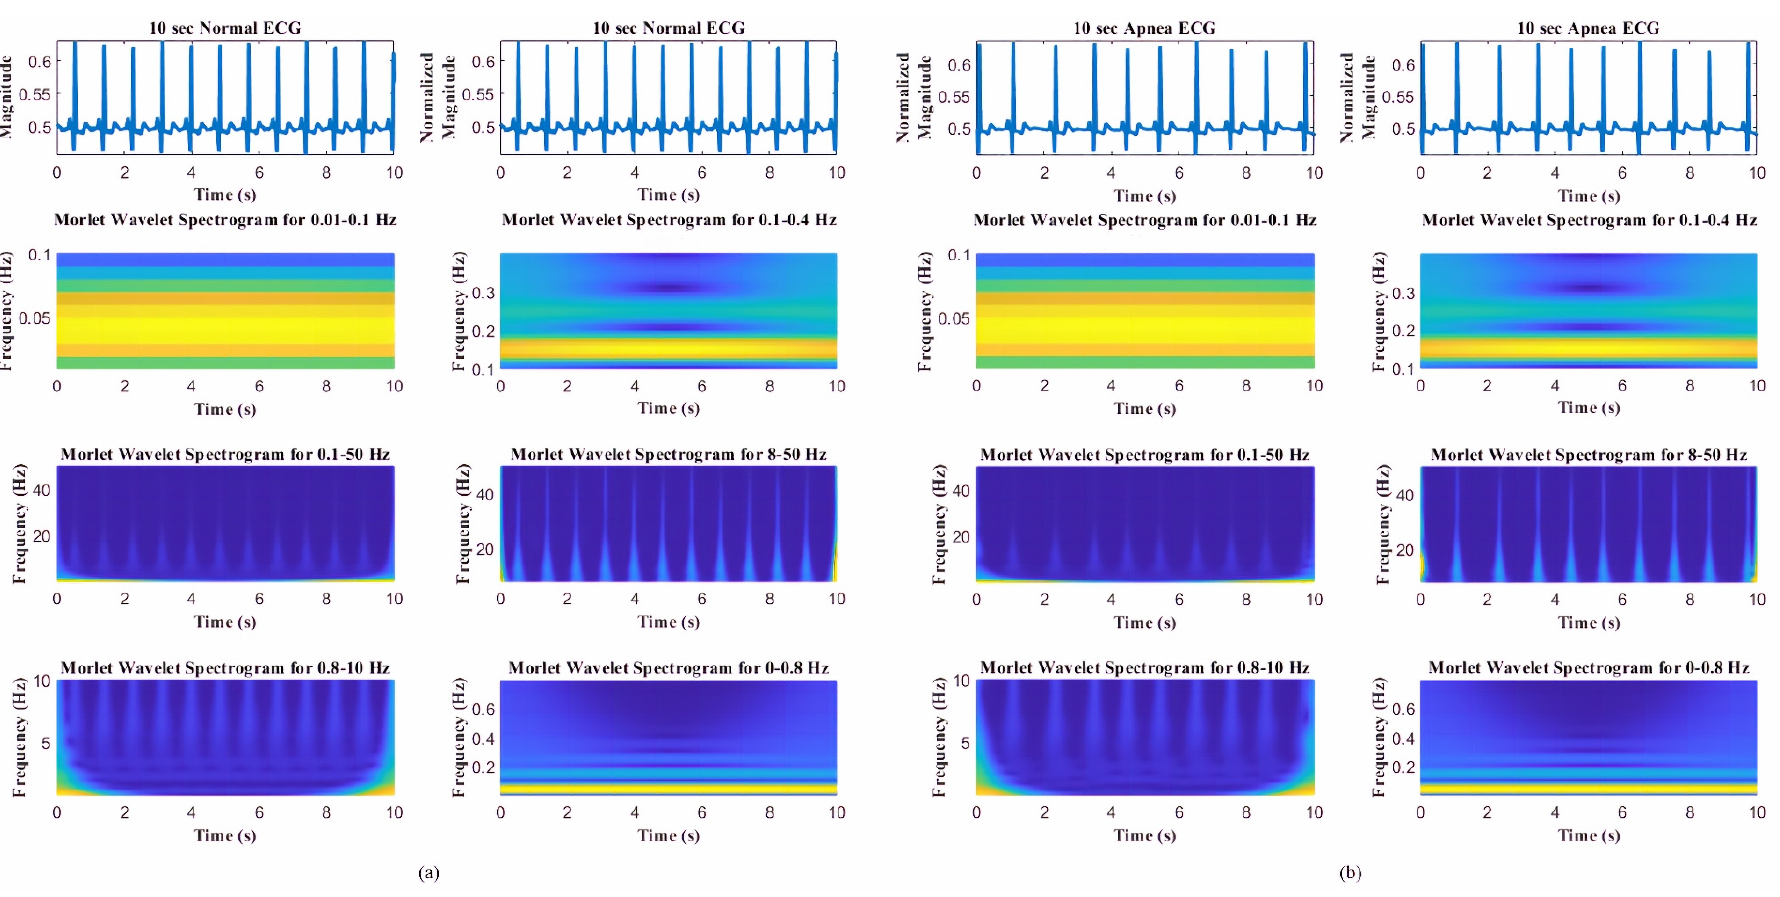
Figure 3. Spectrograms of different frequency bands (0.01–0.1, 0.1–0.4, 0.5–50, 8–50, 0.8–10, and 0–0.8 Hz) [17,18,25] for ( a ) normal ECG and ( b ) apnea ECG events.